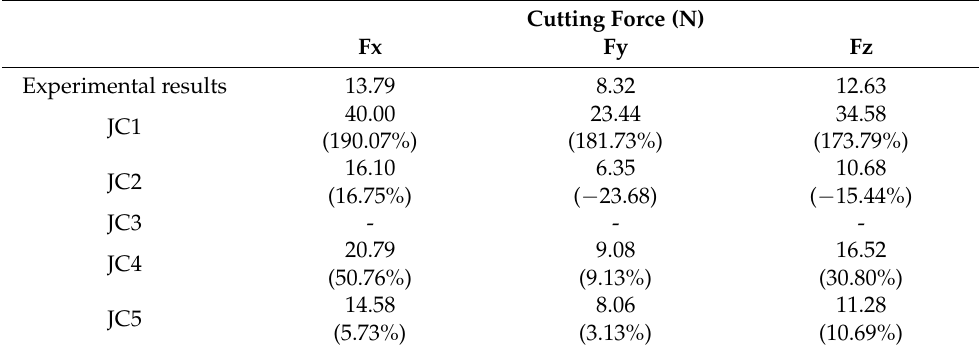
Table 6. Comparison between experimentally and numerically obtained average cutting force (n = 16,000 r/min; ap = 0.2 mm, aw = 0.6 mm. Values in brackets are error